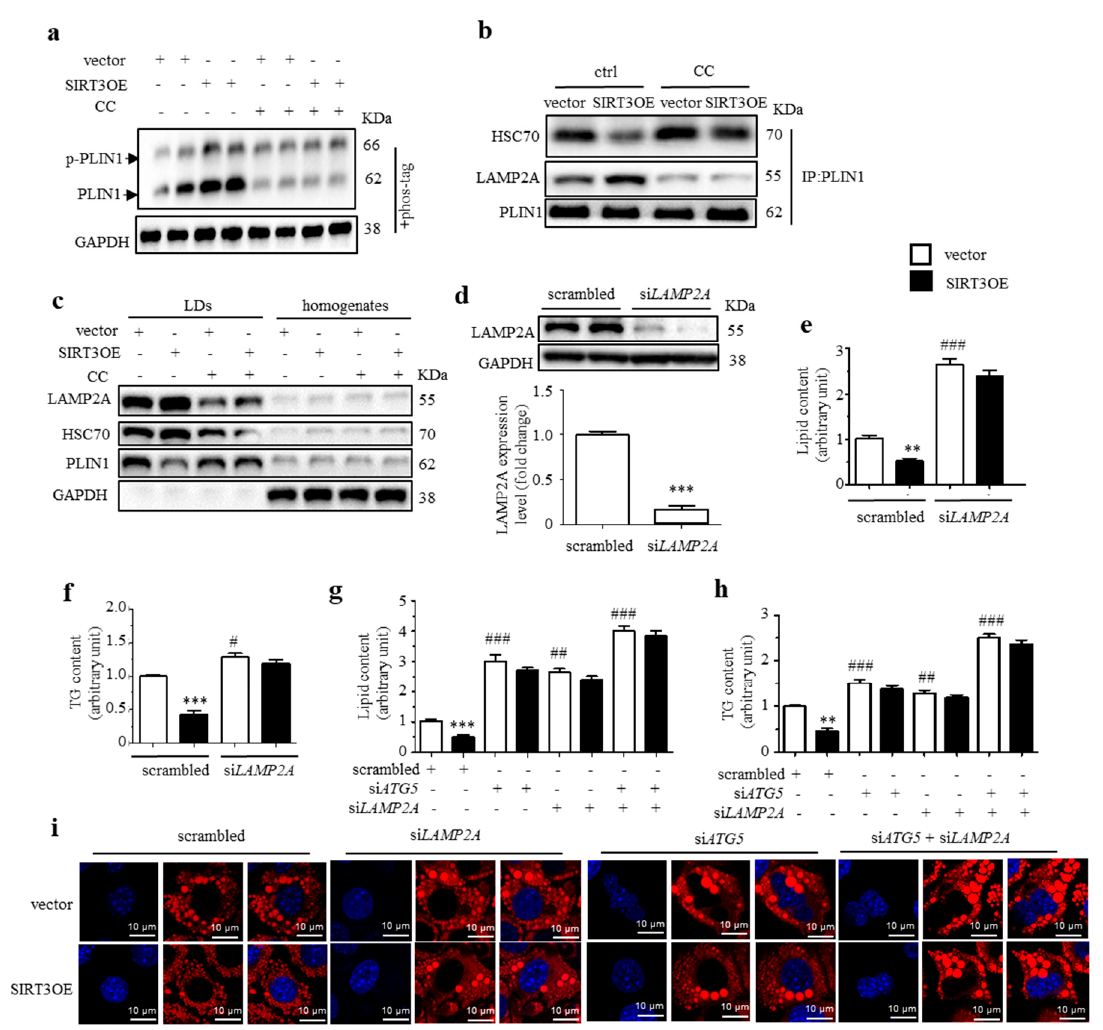
Figure 6. SIRT3 promotes CMA in adipocytes through activating AMPK. ( a ) The phosphorylated and total PLIN1 protein levels in SIRT3OE and vector cells treated with or without CC. GAPDH was used as a loading control. ( b ) The levels of co-precipitated HSC70 and LAMP2 with PLIN1 in vector and SIRT3OE cells treated with or without CC. ( c ) Expression of LAMP-2A, HSC70 and PLIN1 in LDs and homogenates from vector and SIRT3OE cells treated with or without CC. GAPDH was used as a loading control. ( d ) LAMP2A expression in the scrambled and si LAMP2A cell lines. *** p < 0.001 scrambled vs. si LAMP2A . The lipid content ( e ) and the cellular TG content ( f ) in vector and SIRT3OE adipocytes with or without silenced LAMP-2A . ** p < 0.01, and *** p < 0.001 vector versus SIRT3OE cells. # p < 0.05 and ### p < 0.001 scrambled vs. si LAMP2A . The lipid content ( g ) and the cellular TG content ( h ) in vector and SIRT3OE adipocytes with silenced Atg5 , silenced LAMP-2A or simultaneously silenced Atg5/LAMP-2A . ( i ) Intracellular lipid in vector and SIRT3OE adipocytes with silenced Atg5, silenced LAMP-2A or simultaneously silenced Atg5/LAMP-2A was visualized with Nile red (red) staining. Nuclei were stained with DAPI (blue). Scale bar = 10 μ m. ** p < 0.01, and *** p < 0.001 vector versus SIRT3OE cells. ## p < 0.01 and ### p < 0.001 scrambled vs. si LAMP-2A , si Atg5 or si LAMP-2A /si Atg5 . Data are shown as mean ± S.D., n = 6.